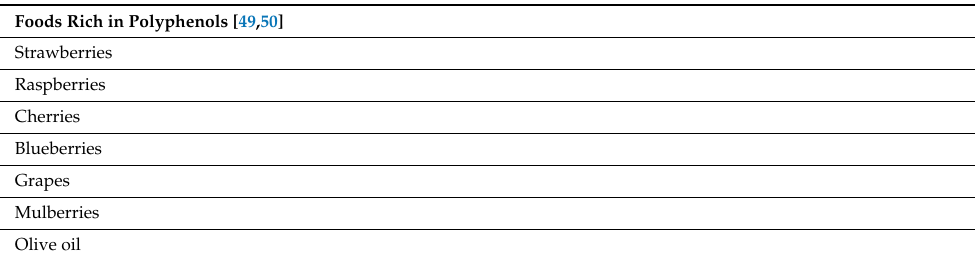
Table 2. Examples of foods rich in polyphenols helpful in reducing oxidative stress, typical of the Mediterranean